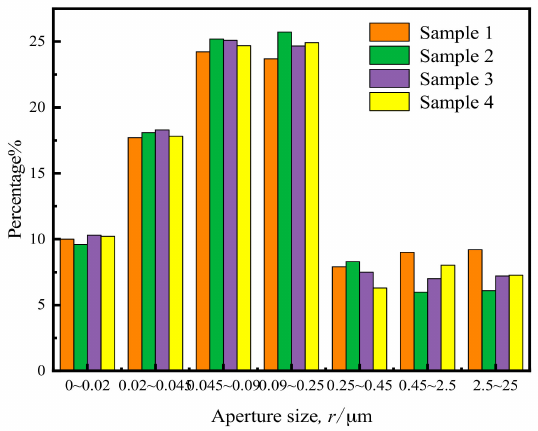
Figure 3. Pore size distribution of different samples.